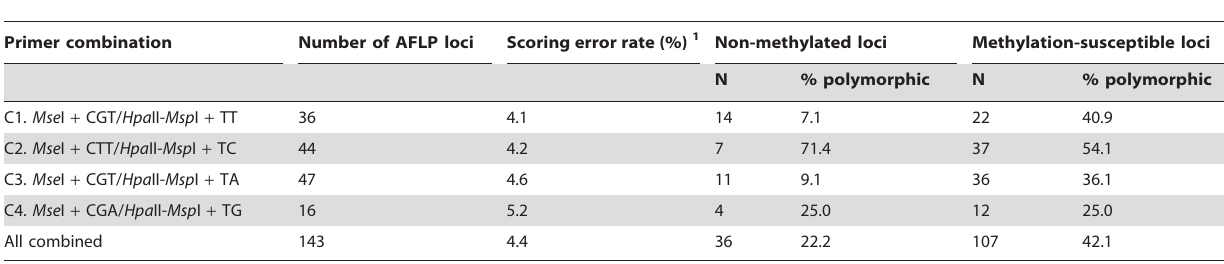
Table 1. Primer combinations used, number of AFLP loci in the size range 150–500 bp, scoring error rates, and frequency and polymorphism of non-methylated and methylation-susceptible loci, in the methylation-sensitive amplified polymorphism (MSAP) analysis of 60 adult plants of Helleborus foetidus from three populations considered in this study.